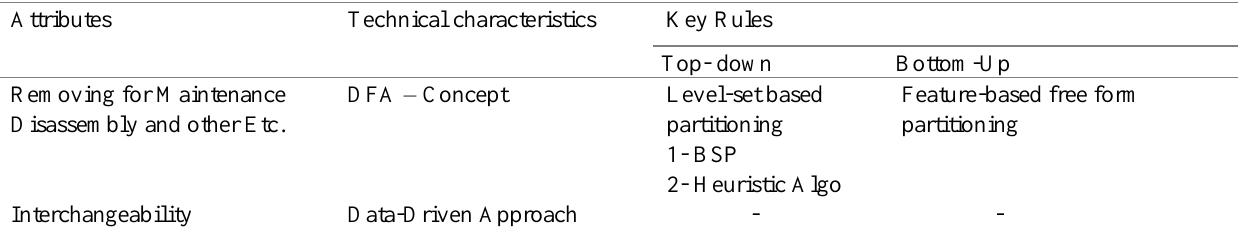
Technical Aspects for AM Pre-Process Planning Attributes Removing for Maintenance Disassembly and other